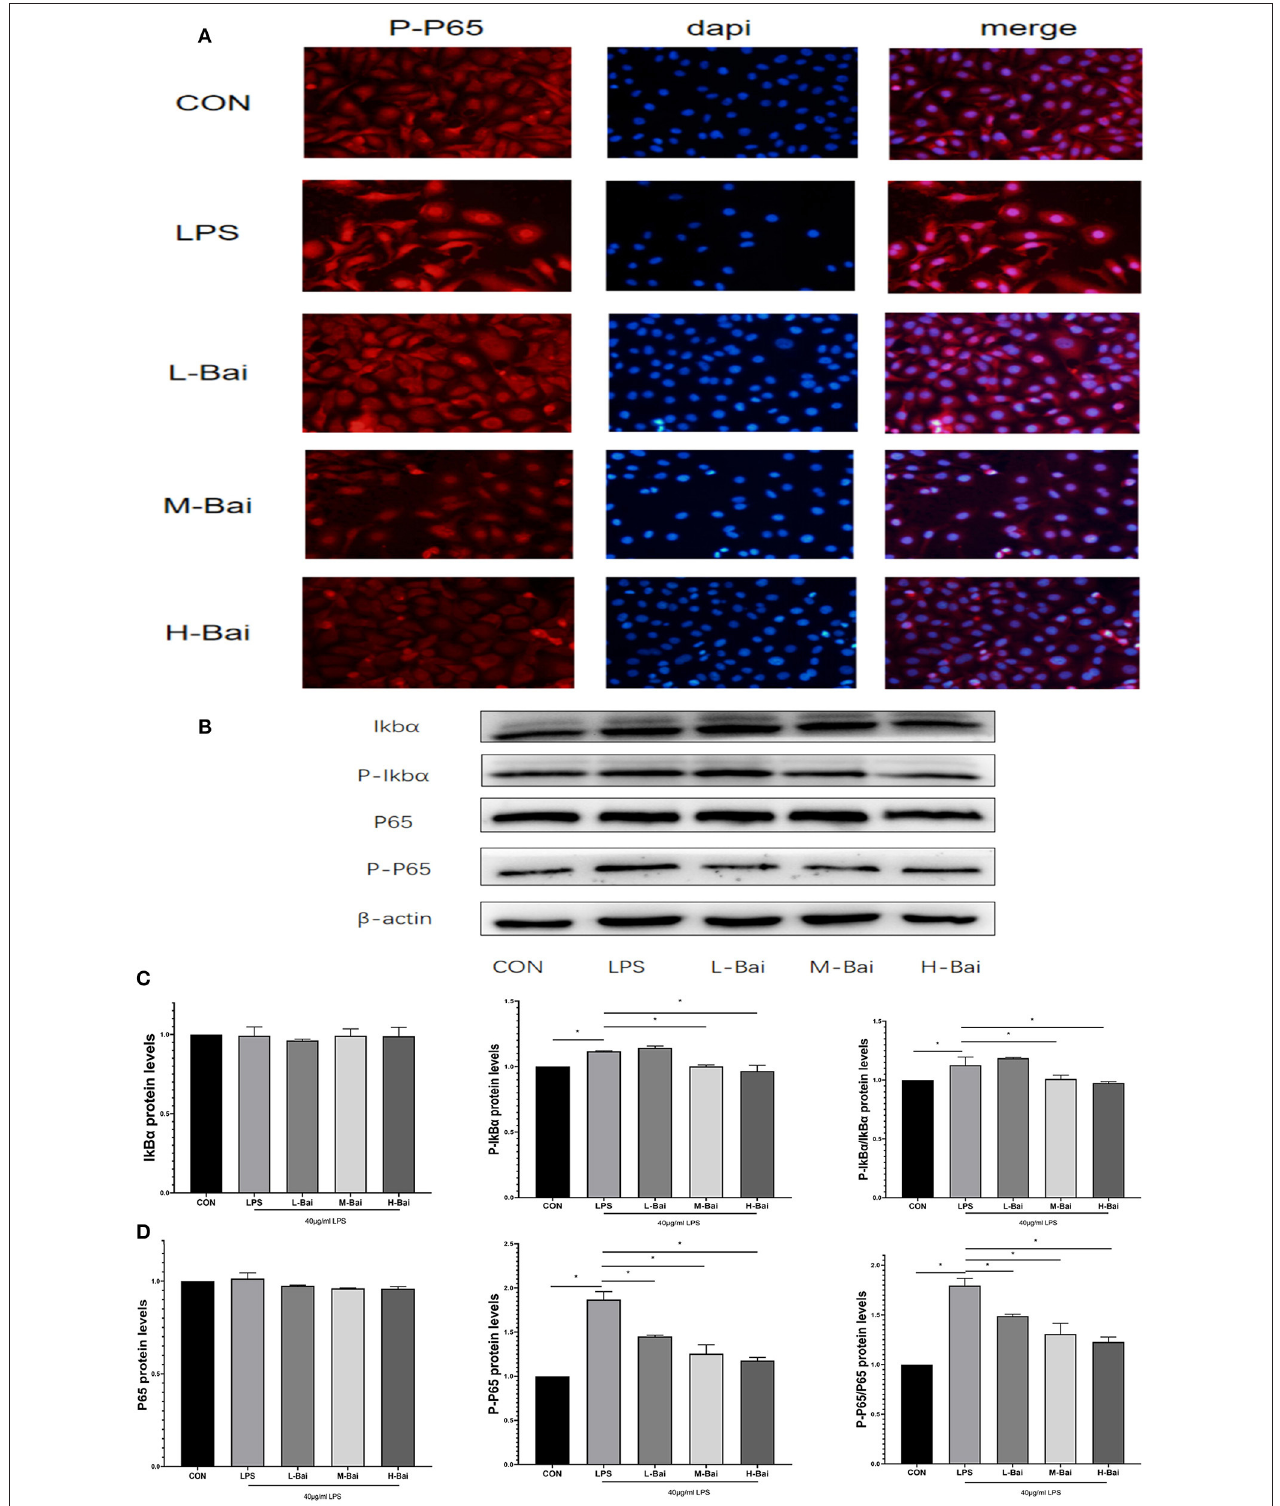
FIGURE 3 | Effects of baicalin on key proteins in the NF- κ B signaling pathway in LPS-stimulated IPEC-J2 cells. Immunofluorescence detection of P-p65 protein nuclear import in IPEC-J2 cells (A) . Western blotting was used to determine the expression of p65, P-p65, I κ B α , and P-I κ B α (B) . p65 and P-p65 protein expression and their ratio (C) . I κ B α and P-I κ B α protein expression and their ratio (D) . Data are presented as the mean ± SEM ( n = 3 per treatment, * p < 0.05 compared with the model group). CON, control; L-Bai, low-concentration baicalin; M-Bai, middle-concentration baicalin; H-Bai, high-concentration baicalin.